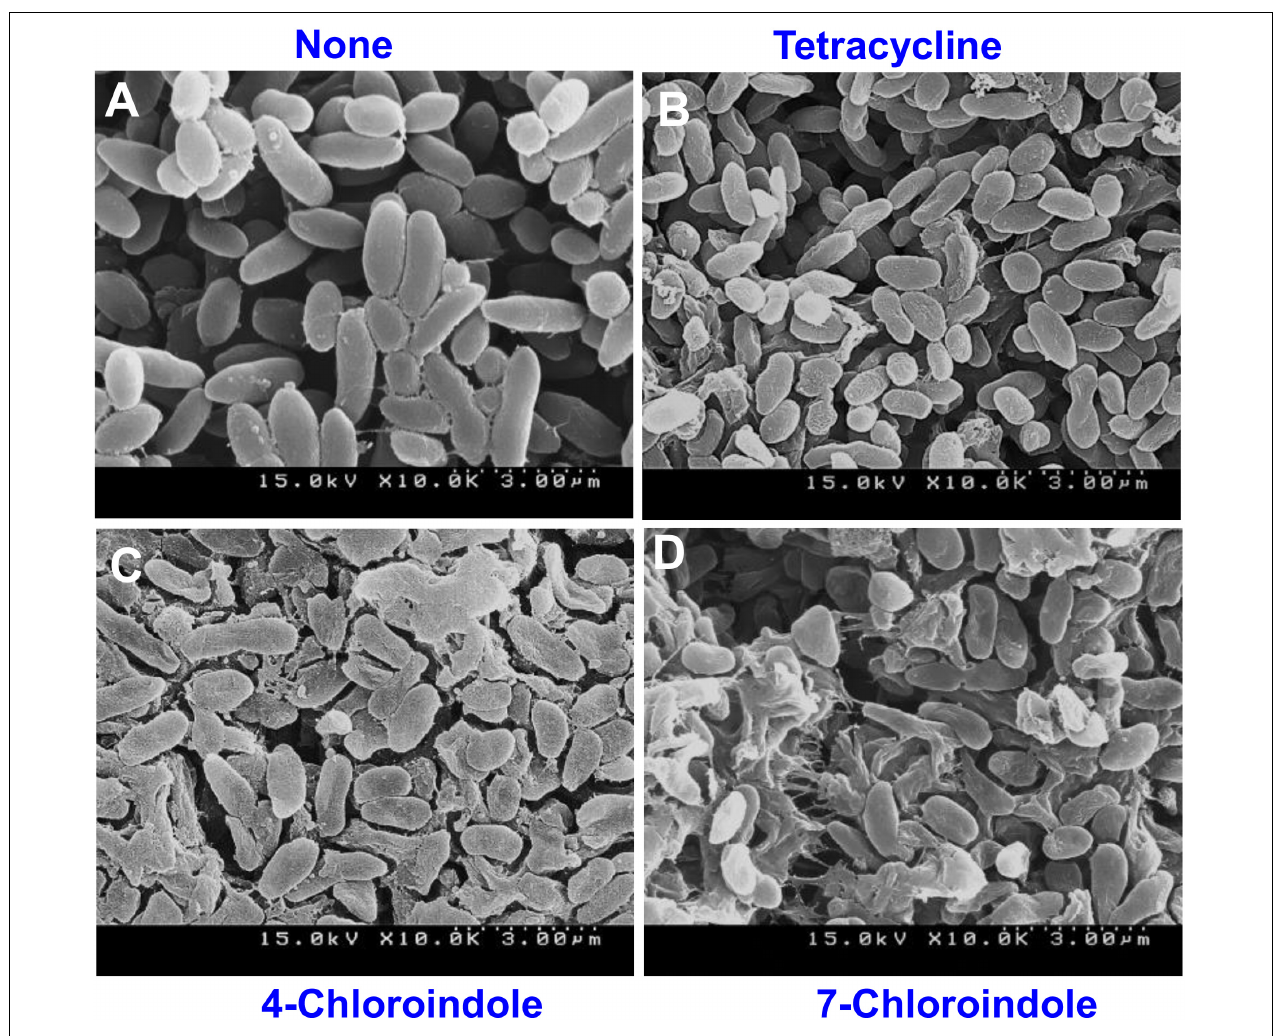
FIGURE 5 | SEM images of V. parahaemolyticus cultured with indoles and tetracycline at 200 µ g/mL. None (A) , tetracycline (B) , 4-chloroindole (C) , and 7-chloroindole (D) .